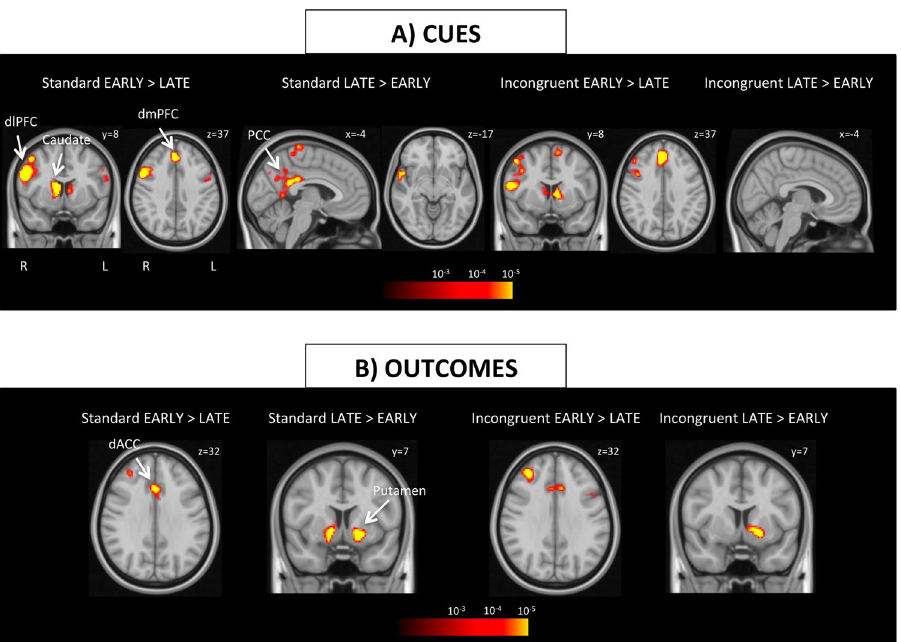
Figure 4. Brain activation during early and late learning phases. ( A ) Regions depicting stronger activation in early (first 2 blocks) versus late phases (last 2 blocks) of learning. Stronger activation was observed in bilateral dorsal caudate, bilateral insula, dmPFC, and right dlPFC during cue presentation in the early phase in both standard and incongruent trials. Conversely, in the late phase, PCC, bilateral postcentral gyrus, and right superior temporal gyrus showed enhanced activation only during standard trials. During outcome presentation, stronger activation was observed in dACC and right dlPFC in the early phase, whereas ventral striatum activation was enhanced in the late phase. All clusters displayed on the maps survive correction for multiple comparisons using a cluster-defining threshold of p < 0.001 and 10,000 Monte Carlo simulations at clusterwise p < 0.05. Abbreviations: dACC: dorsal anterior cingulate cortex, dlPFC: dorsolateral prefrontal cortex, dmPFC: dorsomedial prefrontal cortex, PCC: posterior cingulate